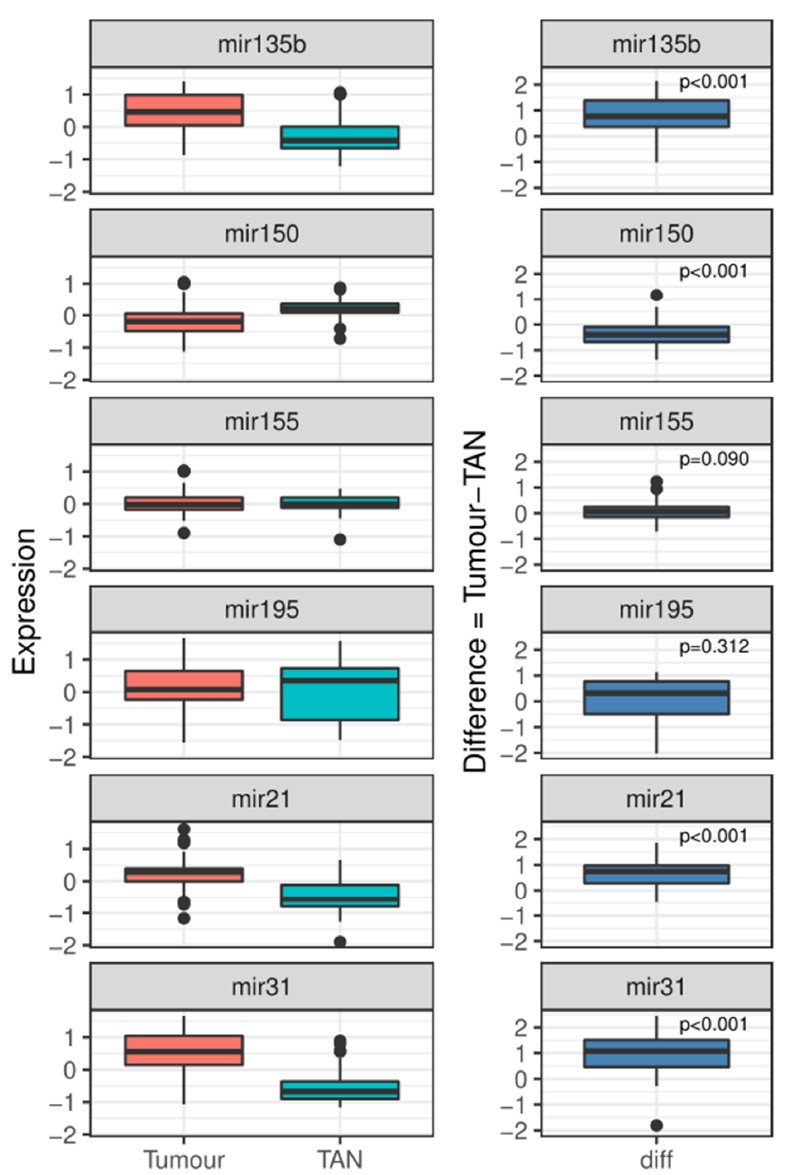
Figure 1. Boxplot analyses illustrating the difference in the mean fold change of miRNA expression in the combined data from discovery and validation sets for comparing tumour samples and tumour-associated normal tissue samples for the six relevant miRNAs. Table 4. Logistic regression univariable and multivariable analyses were used to determine the pre- dictive role of miRNA targets in differentiating tumour samples from tumour-associated normal samples.